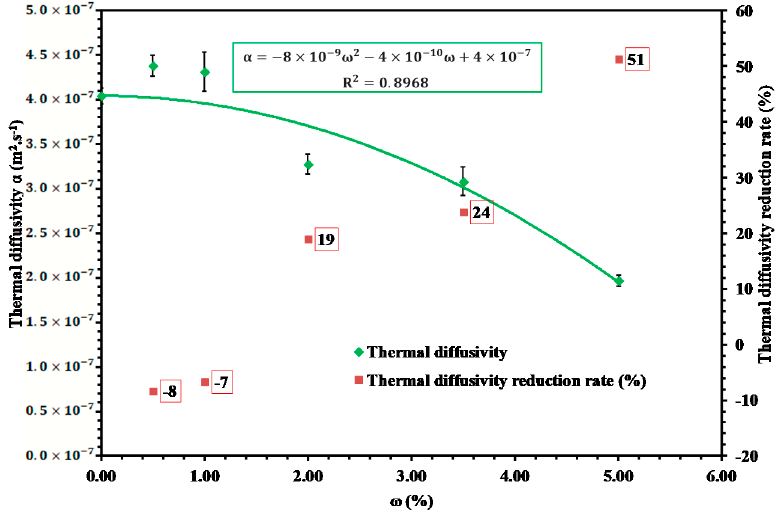
Figure 10. Thermal diffusivity (primary axis) and its reduction rate (secondary axis) as function of AF mass content. Measurements uncertainty is below 5.22%.